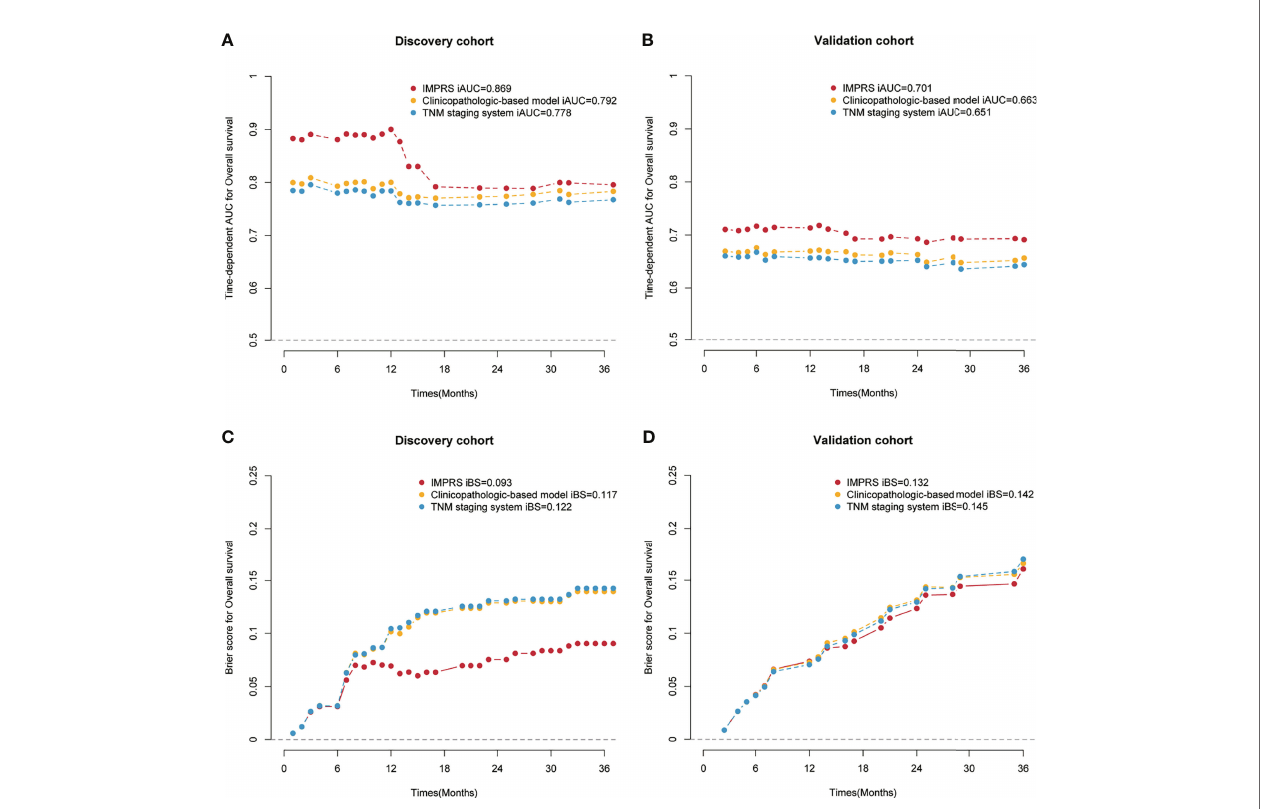
FIGURE 5 | Time-dependent AUC and Brier score for overall survival (OS) in the discovery and validation cohort. (A) Time-dependent AUC for the discovery cohort; (B) time-dependent AUC for the validation cohort; (C) Brier score for the discovery cohort; (D) Brier score for the validation